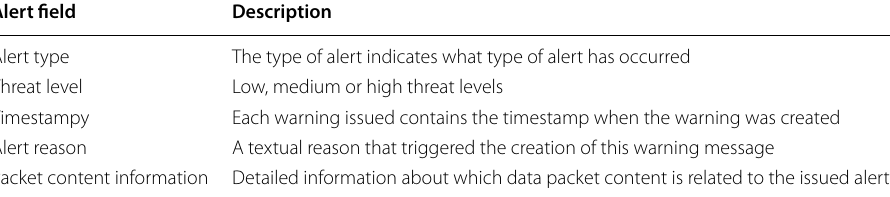
Table 2 Alert output from SIDS Alert